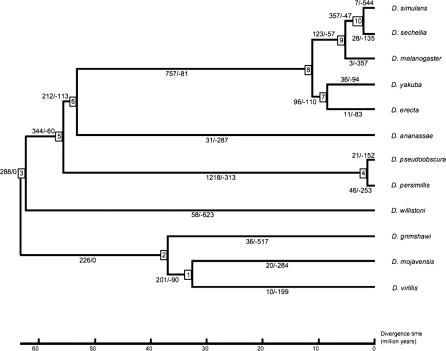
Lineage-Specific and Extinct Gene FamiliesOn each branch the number of lineage-specific families/extinct families are given. Numbers in boxes are identifiers for internal branches of the phylogeny.